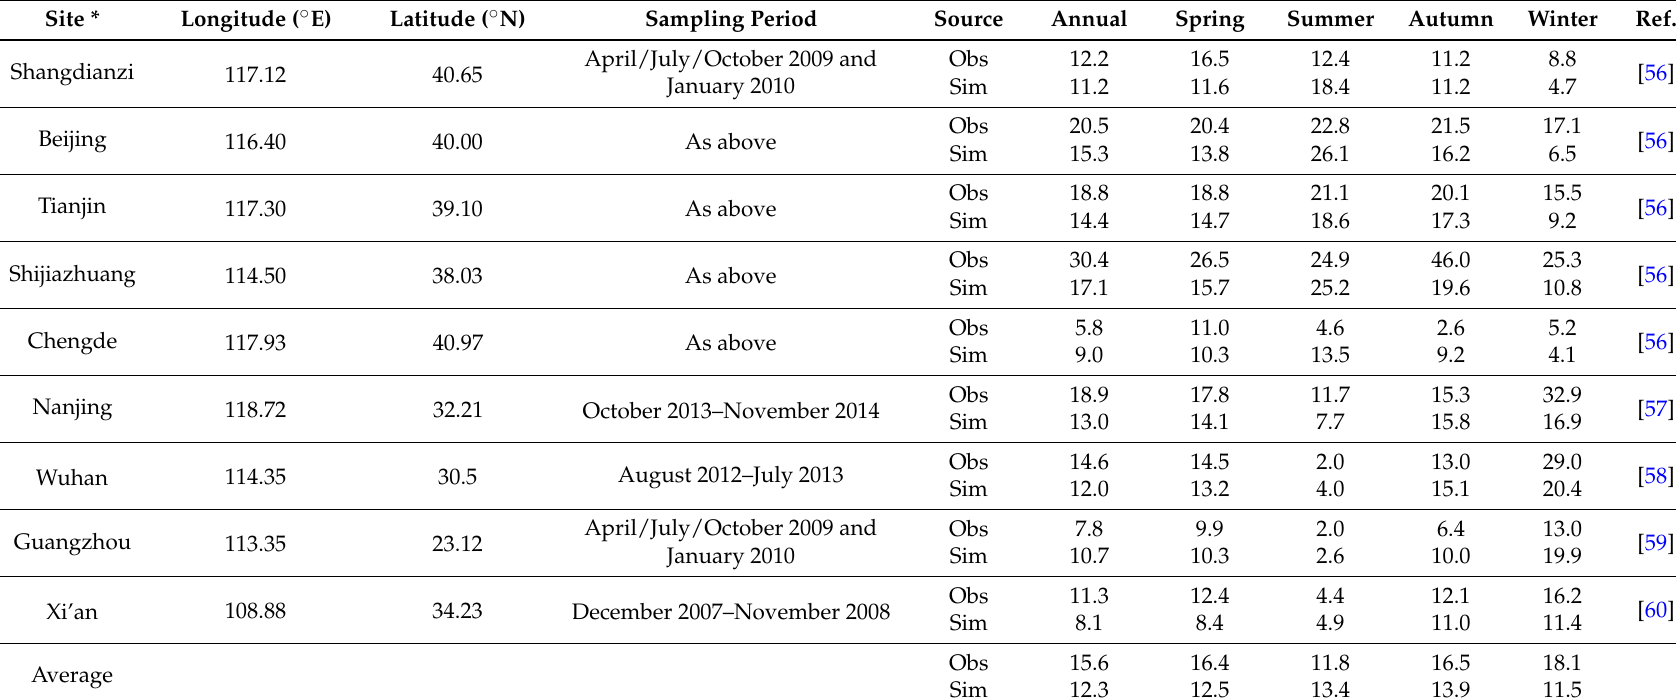
Table 2. Comparison of observed and simulated nitrate concentrations across China (units: µ g ¨ m ´ 3